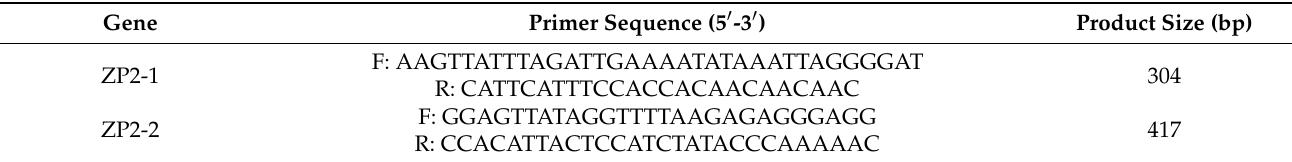
Table 3. Primers of the methylation detection